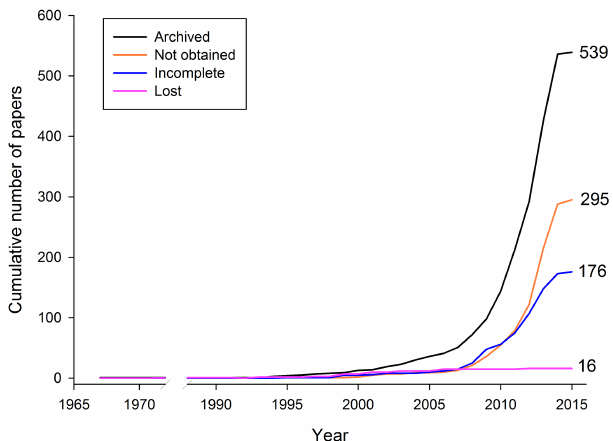
Figure 1. Cumulative number of papers for which data have been included in the compilation (“archived”), papers for which data could not be obtained (“not obtained”), papers which reported less than two carbonate system parameters (“incomplete”) and papers for which the data have been lost